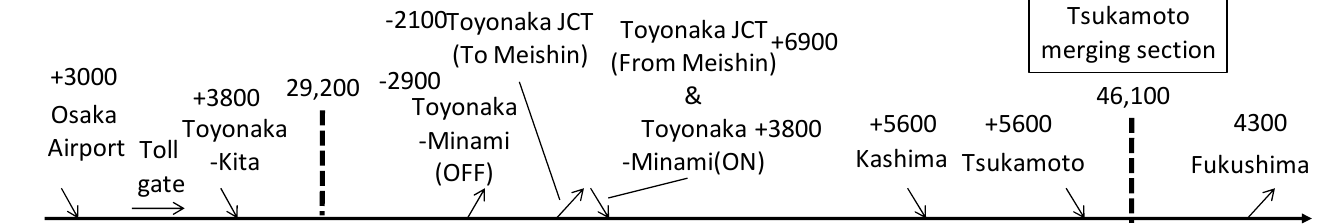
Figure 2. Average traffic volume in 2016.